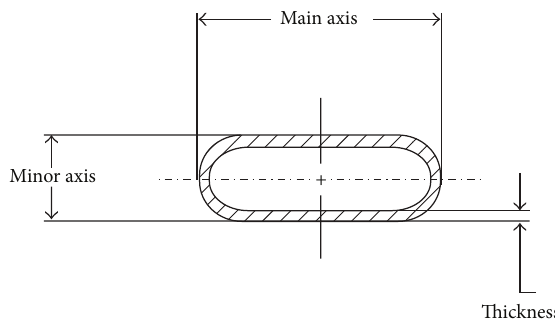
Figure 3: Geometry of expanding tube.